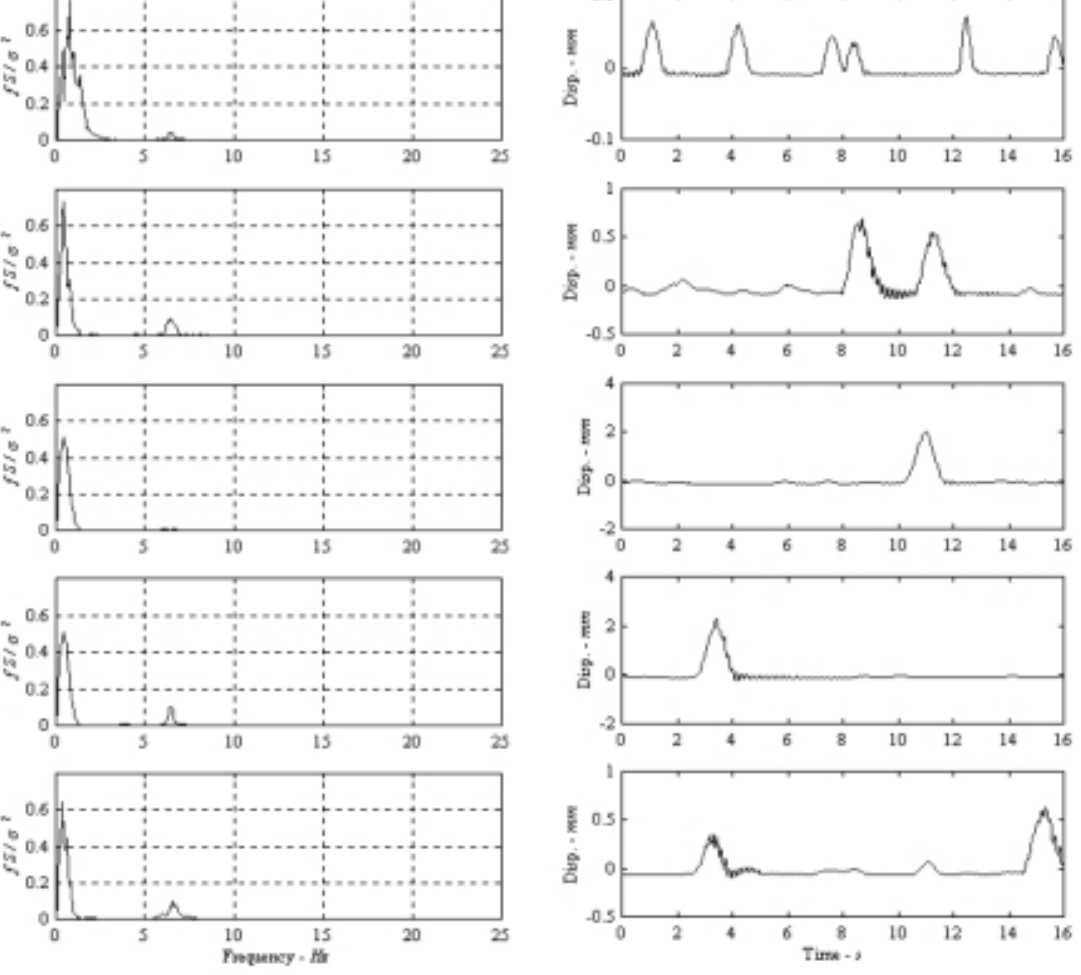
Fig. 9. Typical power spectrum of the 16 seconds records of vibrometer displacement output and corresponding time signals. The peak at ∼ 6 . 5 Hz corresponds to the natural frequency of the bridge excited by the traffic time